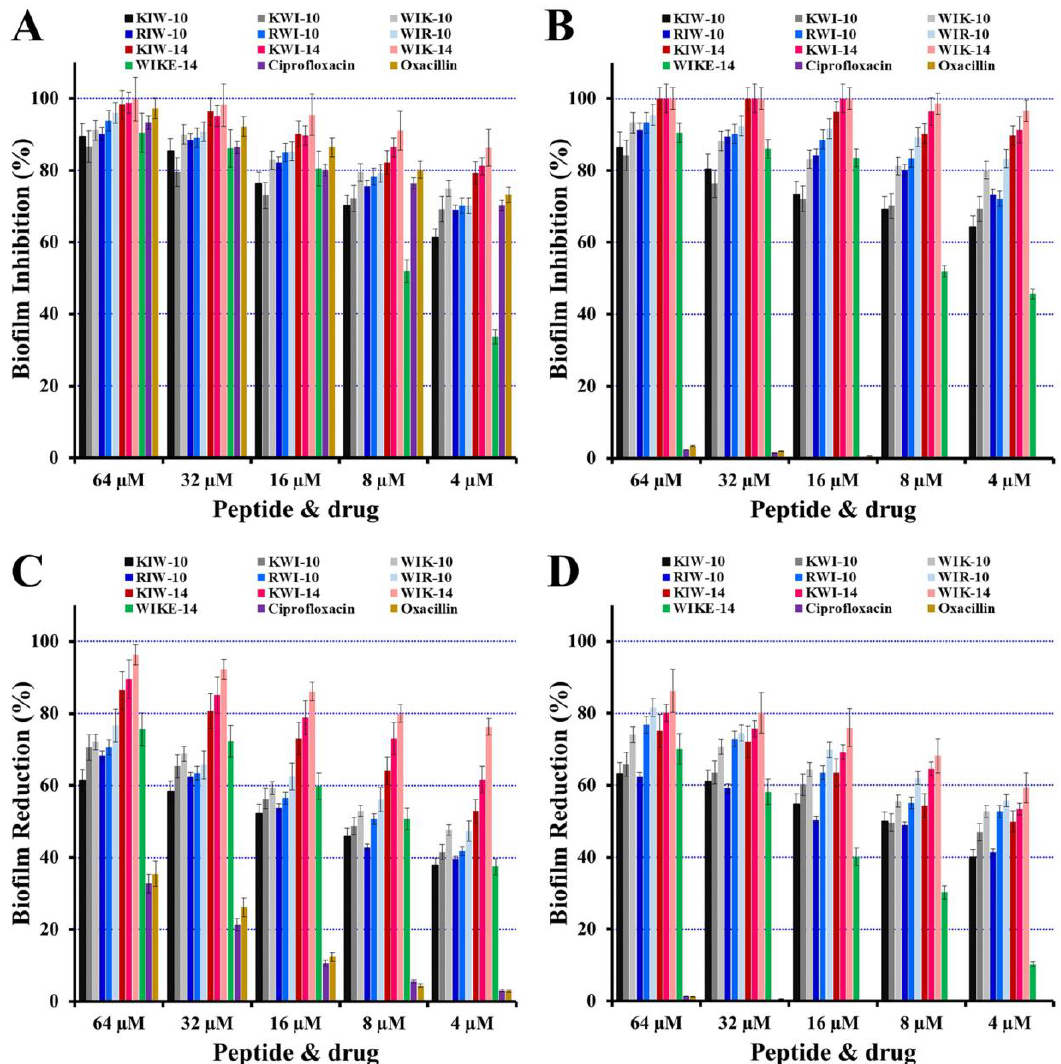
Figure 3. Biofilm-inhibitory ( A , B ) and reductive activities ( C , D ) of peptides and antibiotics in drug- sensitive P. aeruginosa ATCC 27853 ( A , C ) or drug-resistant DRPa 4007 ( B , D ).